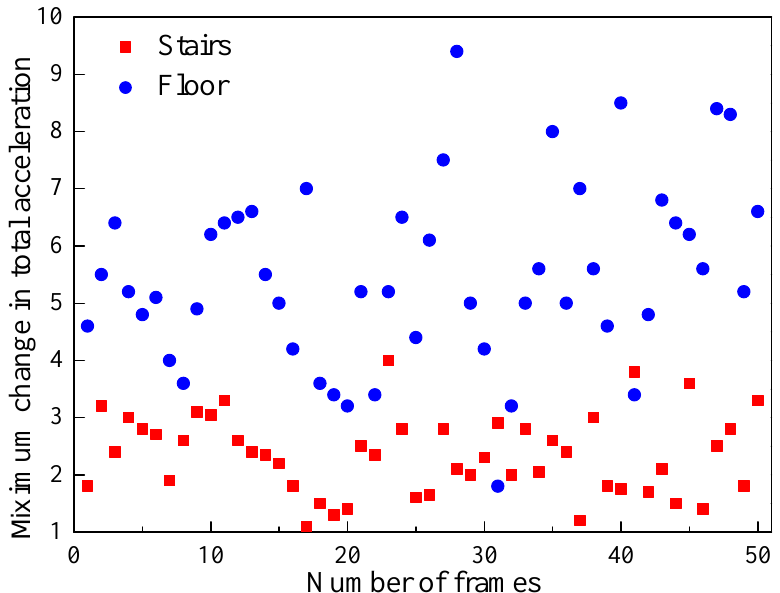
Figure 7. Maximum change in total acceleration.